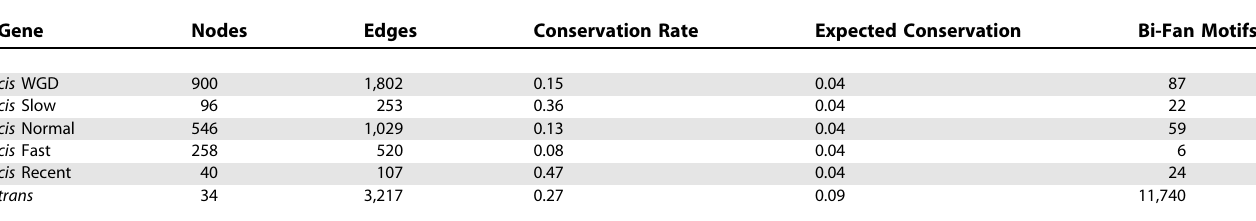
Table 2. Network Properties of Genes Originating from Duplication